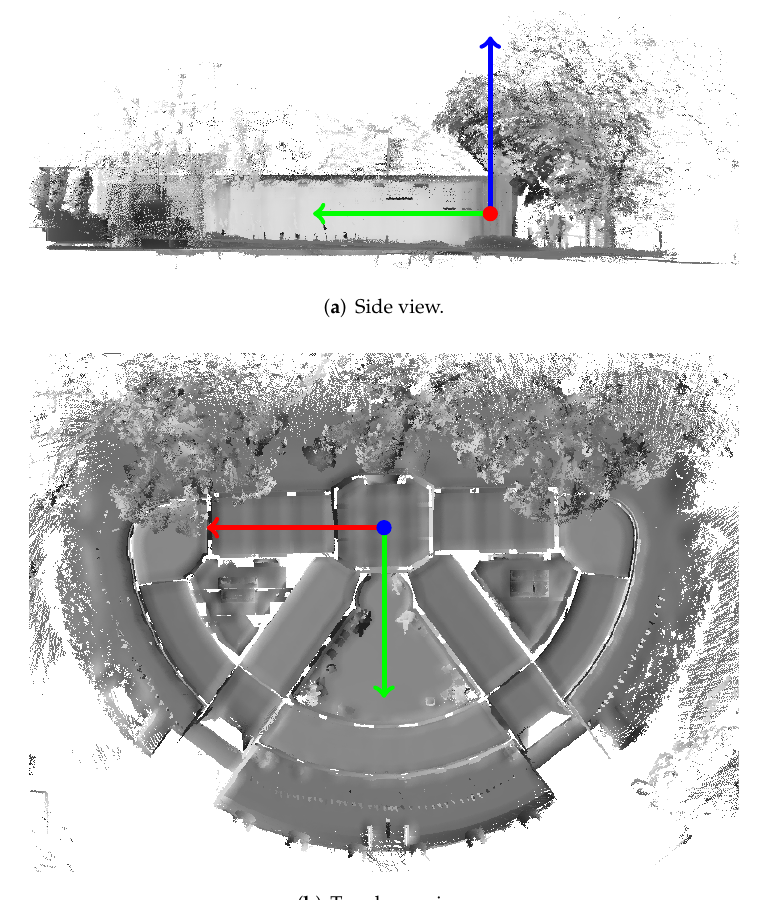
Figure 14. Detailed visualization of the dataset “Case Study 6” from the ISPRS Indoor Modeling Benchmark dataset [96], also depicted in Figure 13f. The depicted axes represent the pose w.r.t. the local coordinate system as resulting from the proposed approach. The vertical axis is visualized in blue, while the two horizontal axes aligned with the dominant Manhattan World structure of the building are depicted in red and green, respectively. Note that, despite the large amount of uneven terrain, vegetation, and building structure deviating from the Manhattan World assumption, the building is aligned w.r.t. the three rooms with the Manhattan World